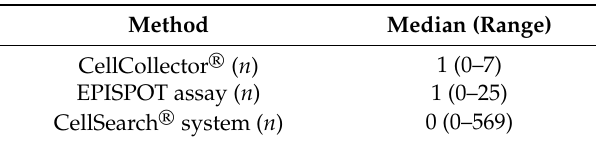
Table 2. Median number of CTCs detected using the CellCollector ® , dual fluoro-EPISPOT PSA / FGF2 assay and CellSearch ®